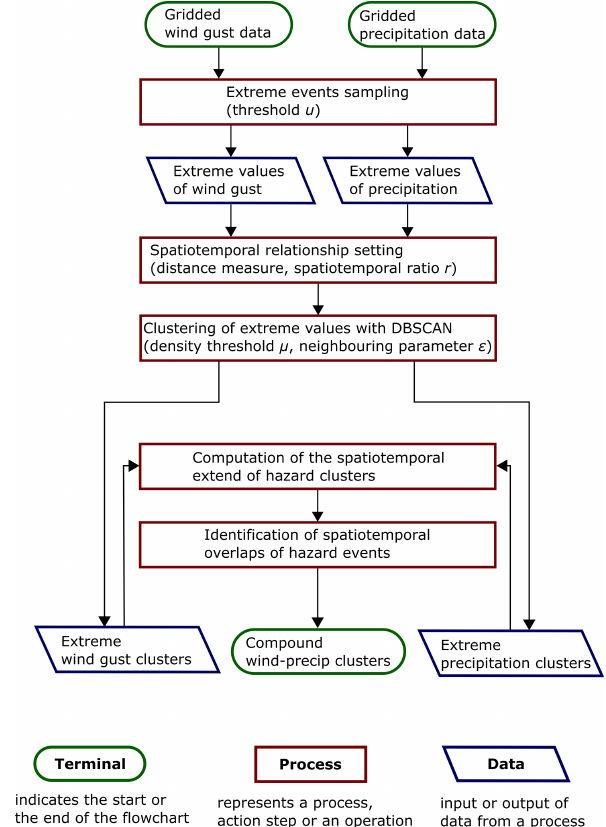
Figure 4. Flowchart of the methodology developed, spatiotem- poral identification of compound hazards (SI–CH), for wind and precipitation data in Great Britain. DBSCAN (Density-Based Spa- tial Clustering of Applications With Noise) is an integral step in our methodology to identify compound hazard clusters in time and space. The name (terminal, process, data) and function associated with the three types of symbols used in the flowchart are given at the bottom of the